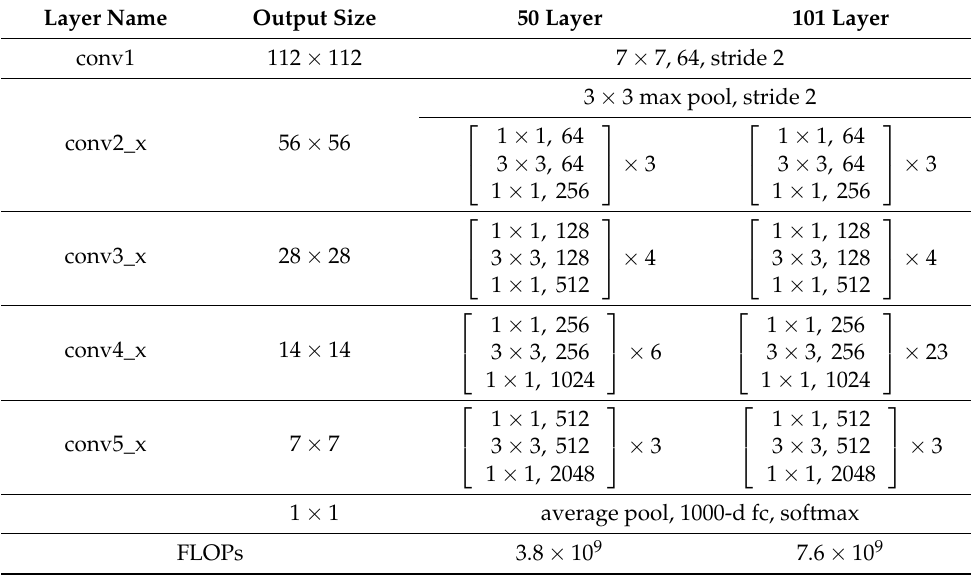
Table 3. Architectures for ResNet-50 and